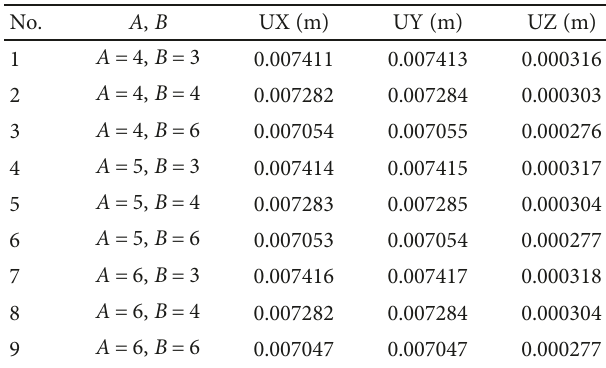
Table 2: Average values of each nodal displacement of 9 design